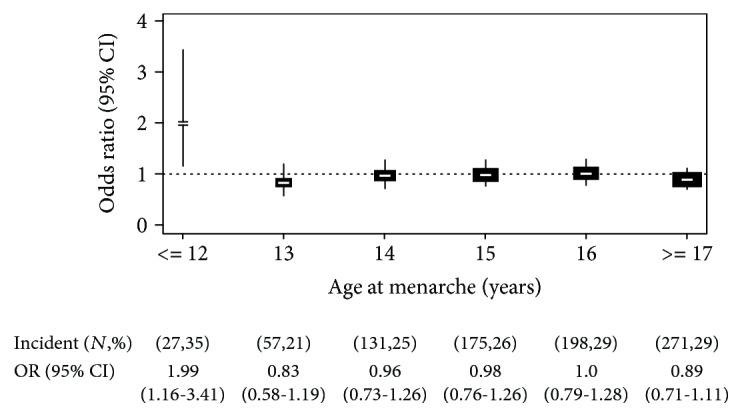
Risk of hypertriglyceridemia in each age at menarche. Odds ratio (OR) and 95% confidence interval (CI) of hypertriglyceridemia by each age at menarche. N is the number of incidence in each age of menarche; % is the percent of incidence in each age of menarche. The size of rectangle represents the number of samples. The vertical line indicates the overall OR on each age of menarche. ORs were adjusted for area, age, income, education, and C-reactive protein levels. The reference category was menarche at 16 years of age.